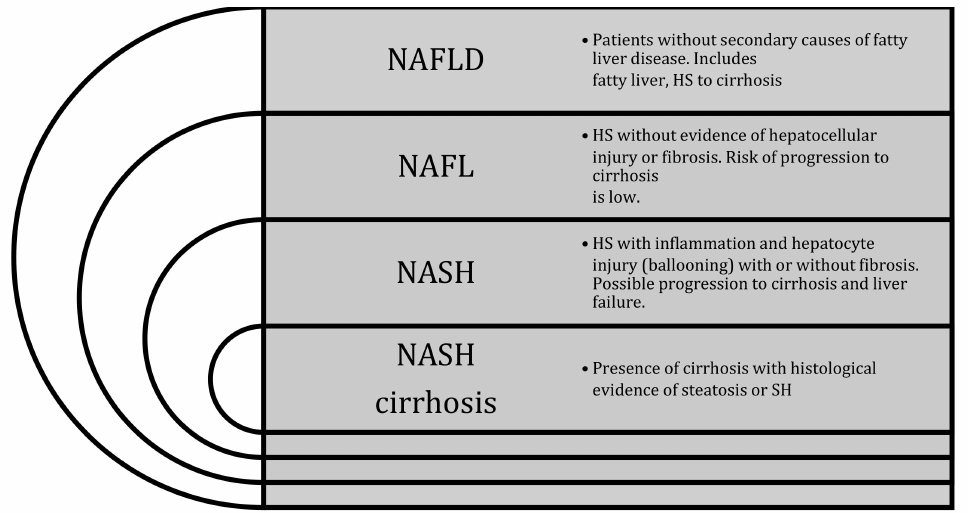
Figure 1. Nonalcoholic fatty liver disease (NAFLD), nonalcoholic fatty liver (NAFL), and nonalcoholic hepatic steatosis (NASH) definitions